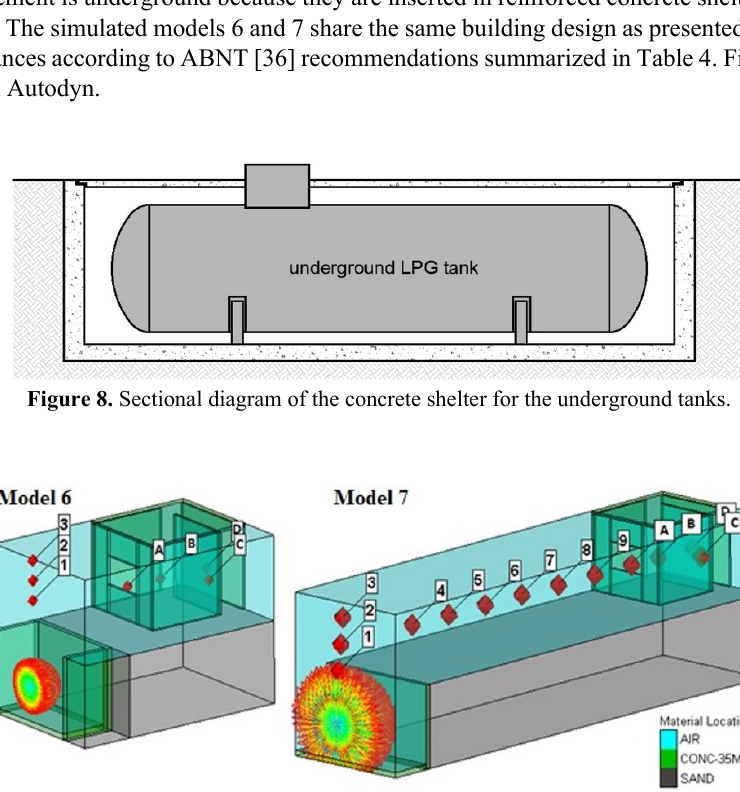
Figure 9. Models 6 and 7 discretized in Autodyn.